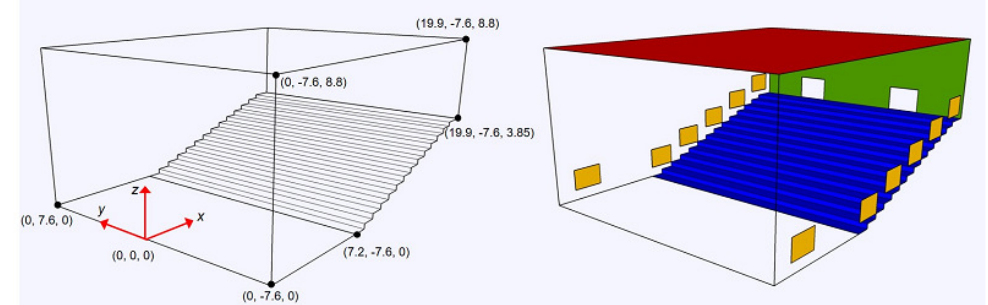
Figure 9. Analyzed auditorium model of 2271 m 3 : ( Left ) dimension and ( Right ) setting of boundary conditions where non-colored surfaces are reflective with frequency-independent impedance and where colored surfaces are absorptive with frequency-dependent impedance of GW (red, yellow), NF (blue), and MPP-GW (green), in which yellow surfaces are assigned absorption properties only in Cond. 2. The yellow surface size is 1.74 m × 1.2 m ( x × z